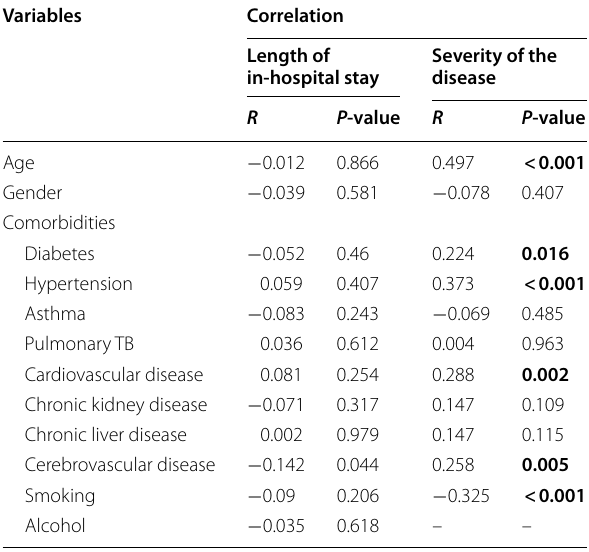
Bold values mean these varibles were statistically